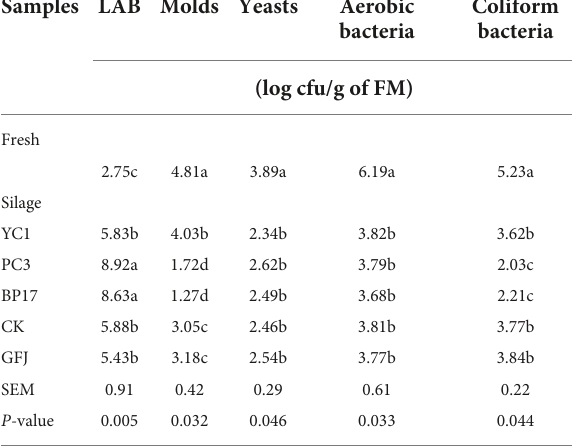
TABLE 2 The microbial population by plate culture of fresh and ensiled paper mulberry. Samples LAB Molds Yeasts